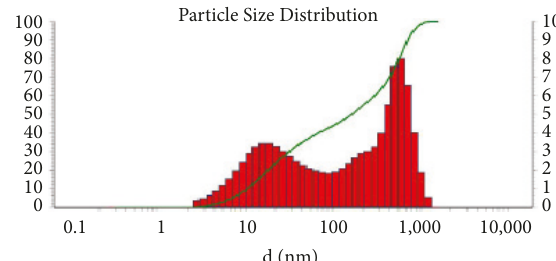
Figure 4: Particle size analysis of zinc oxide-activated carbon nanocomposite.